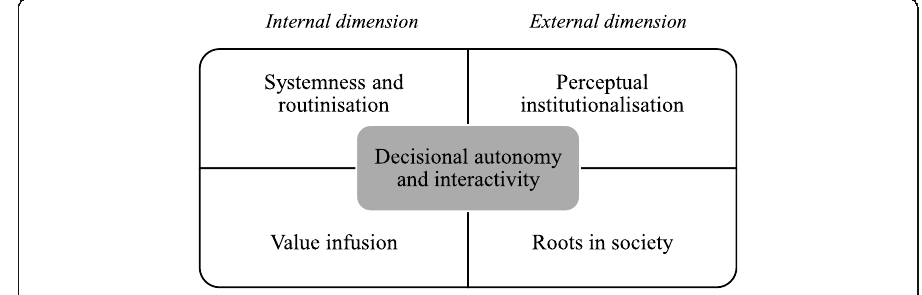
Fig. 1 Institutionalization dimensions for transnationalizing